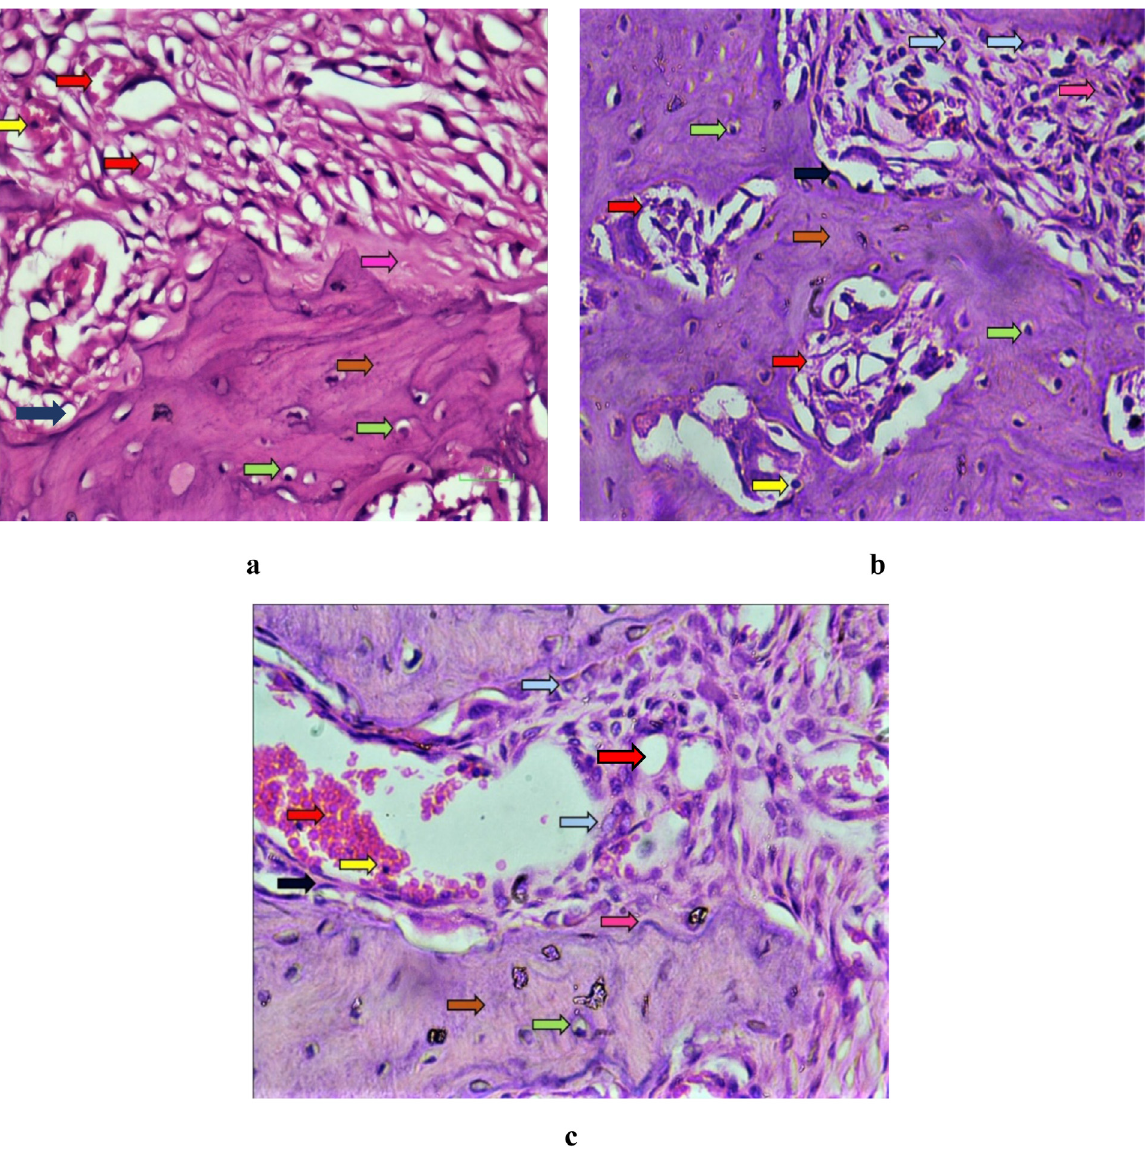
Fig. 7. Photomicrograph of Group A (control) (a), B (mucoadhesive paste with phenytoin) (b), and C (mucoadhesive paste without phenytoin) (c), 14 days after extraction, H and E stain, 40 (cid:3) . Blood vessels (red arrows) are seen with in fl ammatory cells (yellow arrow). Fibroblasts are mostly arranged in a symmetrical manner. Ground substance (pink arrow) is evident with bone tissue. Mineralized bone matrix (brown arrow) is seen having bone forming cells along the borders (dark blue arrows). Osteocytes are also evident within the bone tissue (green